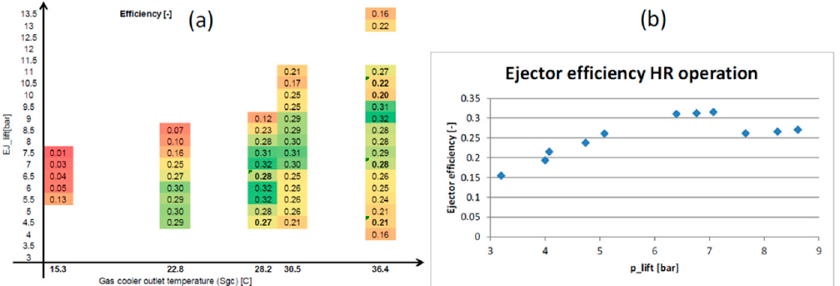
Figure 17. Comparison between the ejector efficiencies measured in the laboratory ( a ) and those estimated in a real application performing in heat recovery mode ( b ) [55].